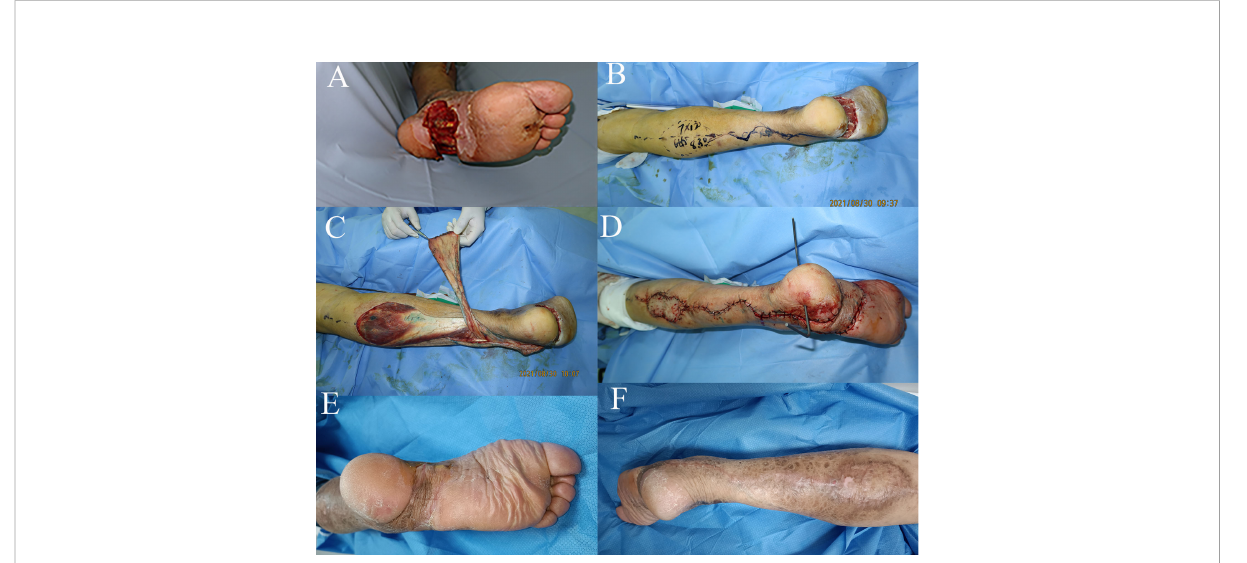
FIGURE 2 Case 2: The distally based sural neurocutaneous fl aps for reconstruction of the sole soft tissue defect. (A) Diabetic wound at the sole. (B) Design of the fl ap. (C) Harvest of the distally based sural neurocutaneous fl ap. (D) The defect was reconstructed with a fl ap, and the donor site was covered with skin graft. (E, F) The fl ap and the donor site were completely healed at follow-up.